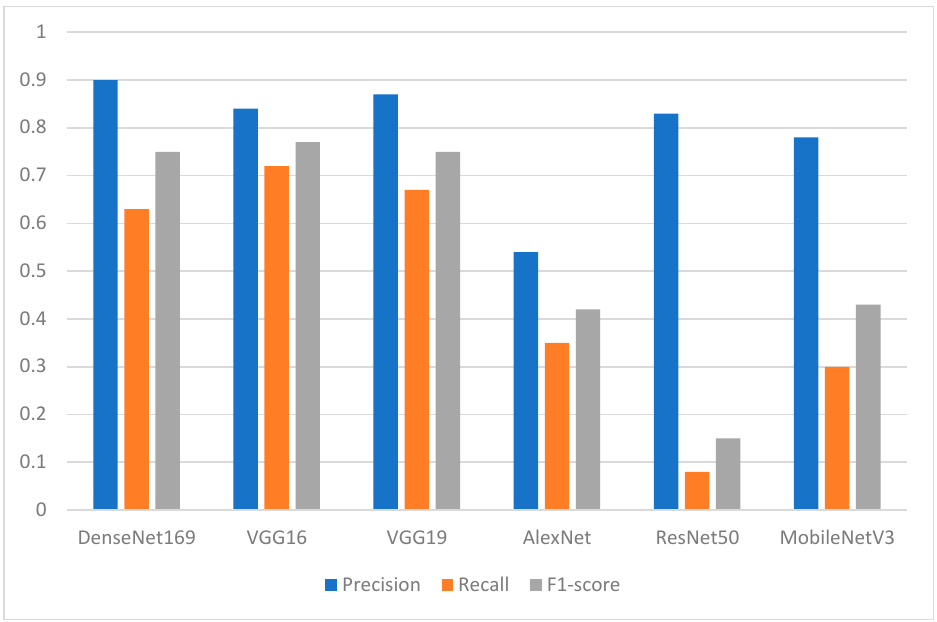
Figure 13. Performance of the models in terms of precision, recall, and F1-score concerning class 0 (class of normal teeth).